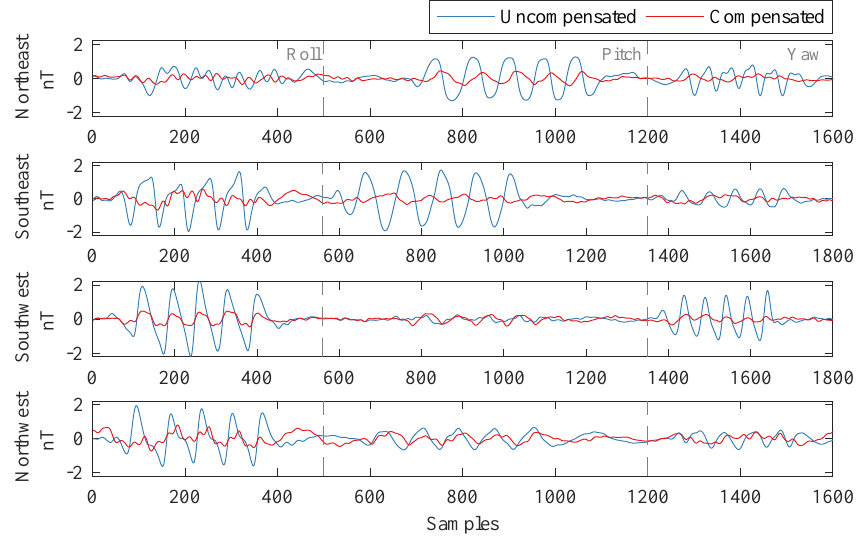
Figure 9. The compensated signal of Dataset-C. The coefficients are calculated from